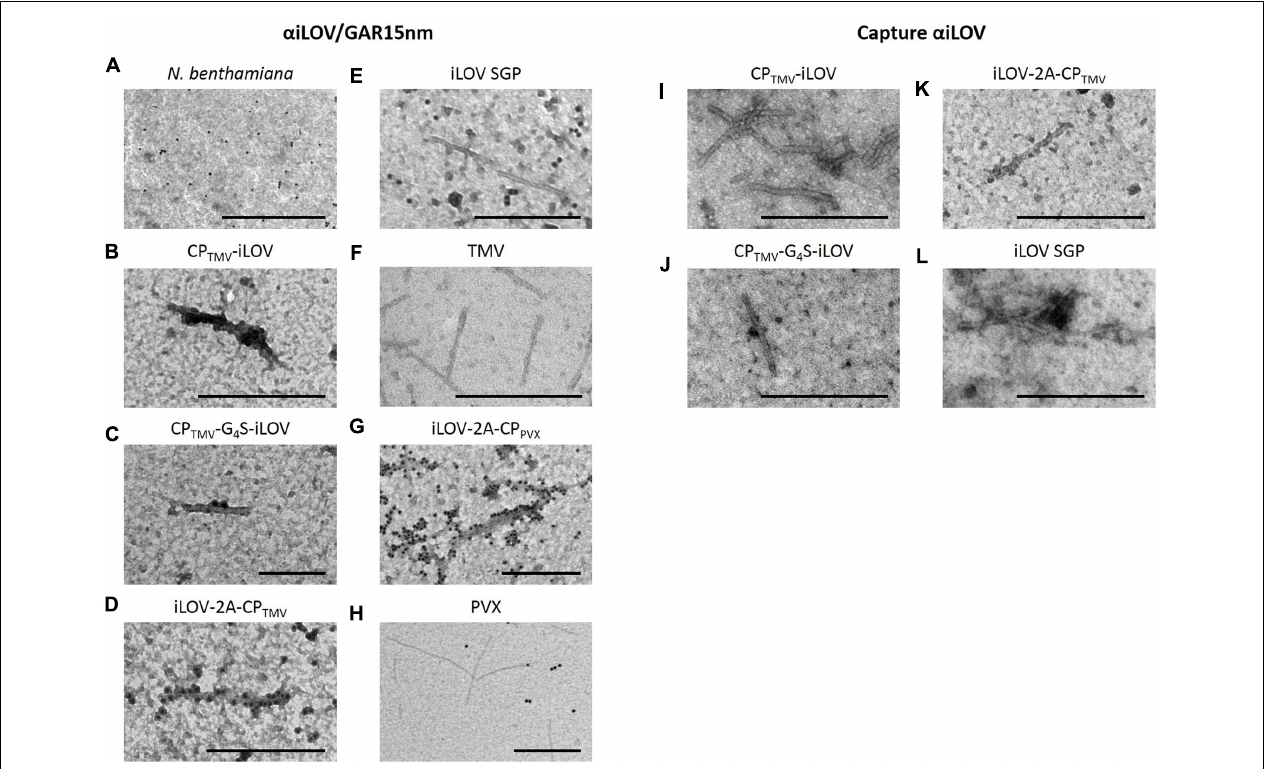
FIGURE 4 | Electron micrographs of infected leaf extracts expressing recombinant TMV and PVX particles displaying iLOV. (A–H) Immunogold decoration: (A) Non-infected N. benthamiana leaf extract, (B) CP TMV -iLOV, (C) CP TMV -G 4 S-iLOV, (D) iLOV-2A-CP TMV , (E) iLOV SGP, (F) TMV particles, (G) iLOV-2A-CP PVX , and (H) PVX particles. The particles were detected with an iLOV-specific antibody and a goat anti-rabbit secondary antibody labeled with 15-nm gold. (I–L) Enrichment of particles by capturing with iLOV-specific antibody: (I) CP TMV -iLOV, (J) CP TMV -G 4 S-iLOV, (K) iLOV-2A-CP TMV , (L) iLOV SGP. Bar = (A) 1 µ m, (B,D–L) = 500 nm, (C) = 200